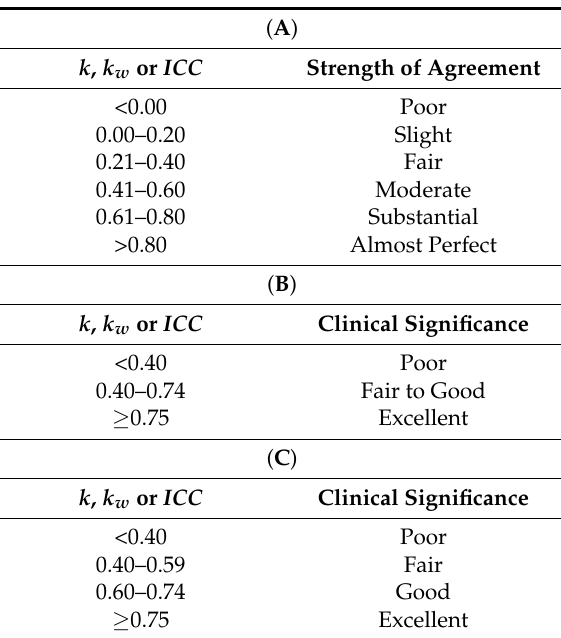
Table 1. ( A ) The Landis and Koch (1977) Criteria for Assessing Enological Significance; ( B ) The Fleiss (1981) Criteria for Assessing Enological Significance; ( C ) The Cicchetti and Sparrow (1981) Criteria for Assessing Enological